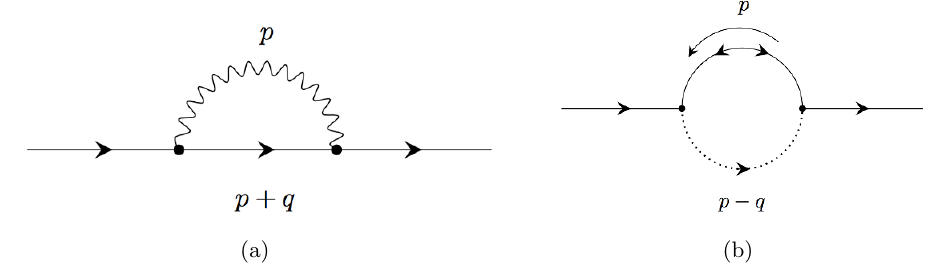
Figure 4 . The electron self-energy at one-loop in the N = 1 theory.